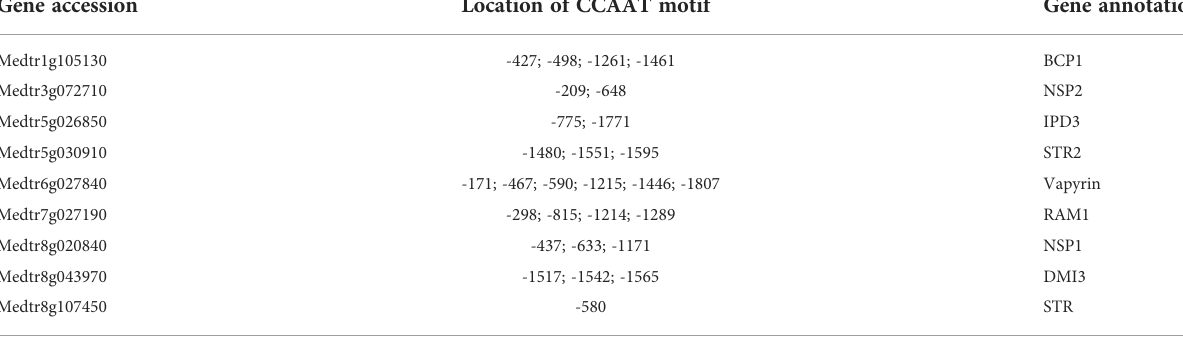
TABLE 2 The location of CCAAT motifs extracted from 2 kbp upstream region of AMS marker genes included in this